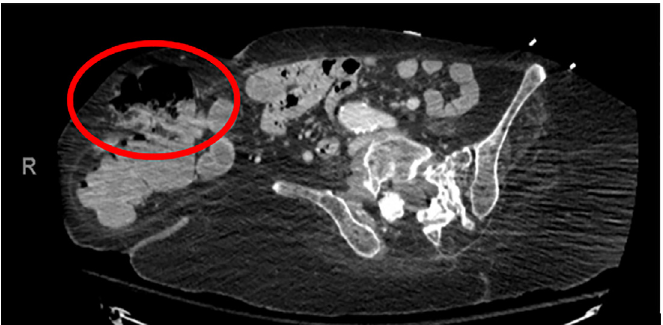
Image 2. Computed tomography with intravenous contrast of the abdomen and pelvis. No active extravasation was found, and in the circled area above in the parastomal hernia (large red circle).